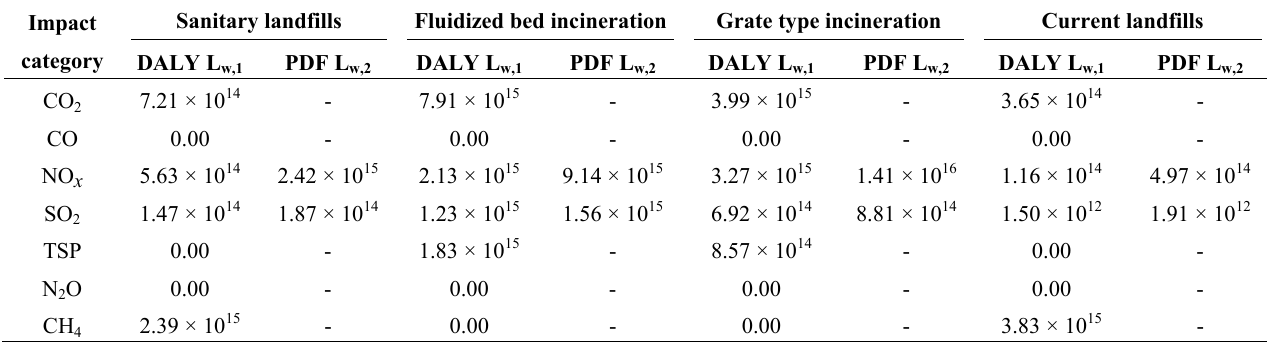
Table 6. Emergy analysis table of emissions’ impacts (Unit: